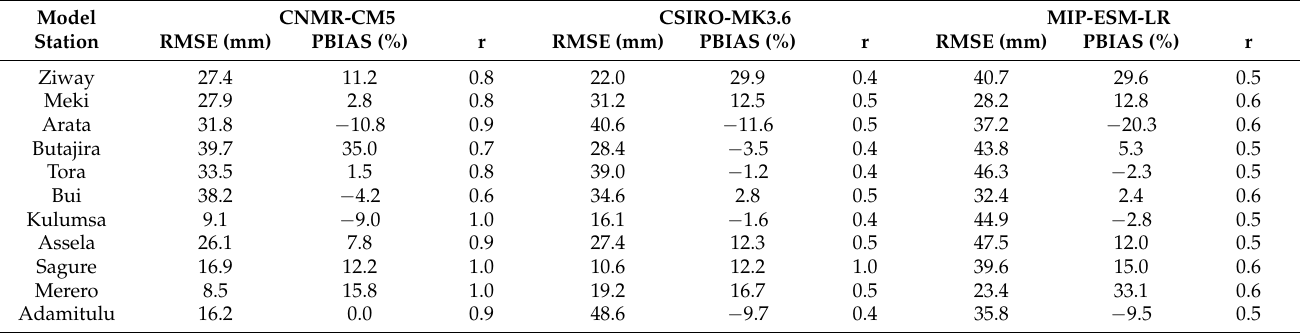
Table A1. Statistical performance indices of the GCMs–CMIP5 for monthly rainfall of 1983 to 2005.